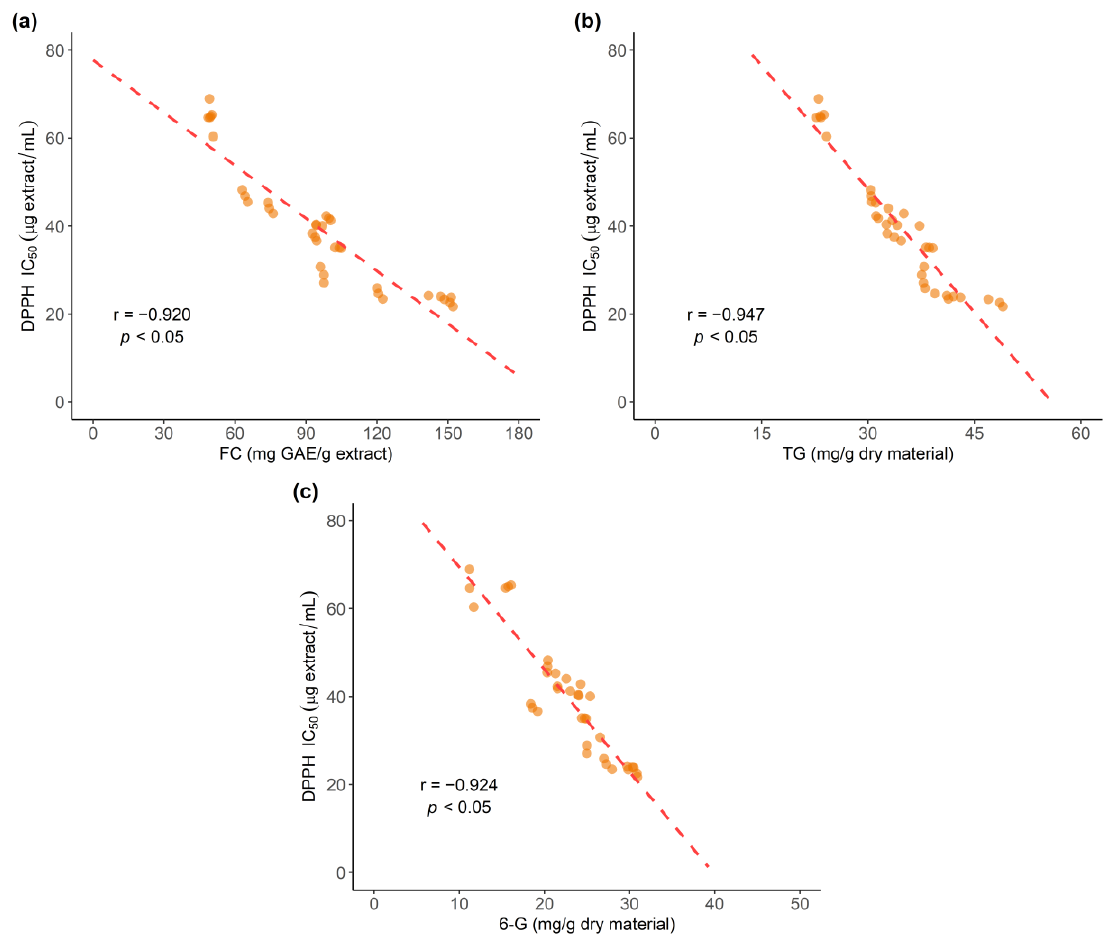
Figure 13. Correlation of antioxidant activity assessed by the DPPH method with ( a ) Reducing ca- pacity by Folin – Ciocalteu; ( b ) TG by UPLC; and ( c ) 6-gingerol by